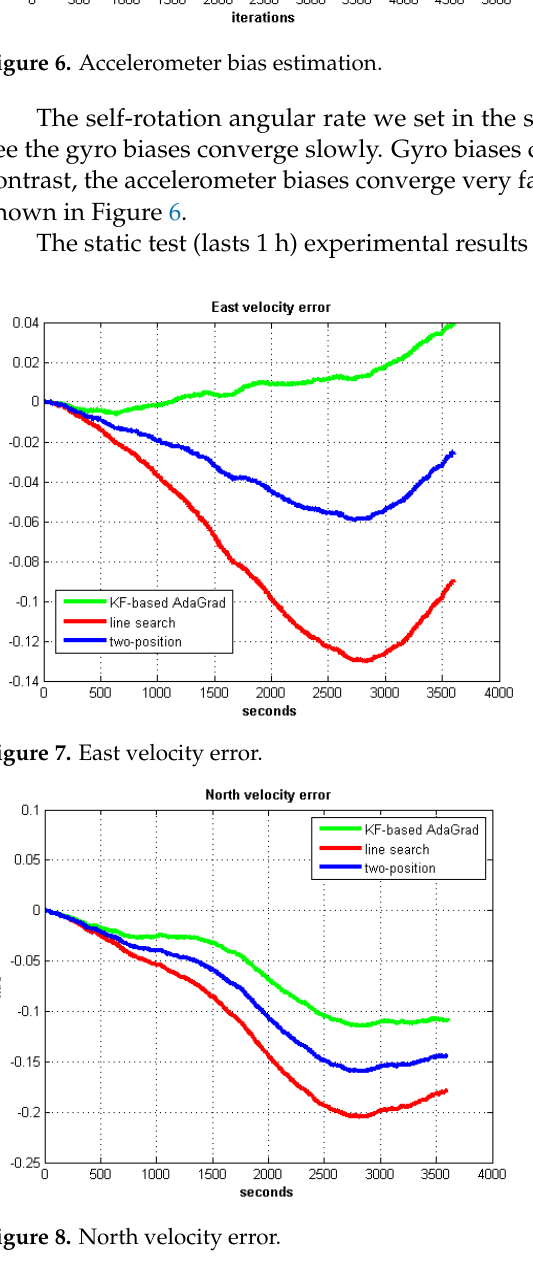
Figure 8. North velocity